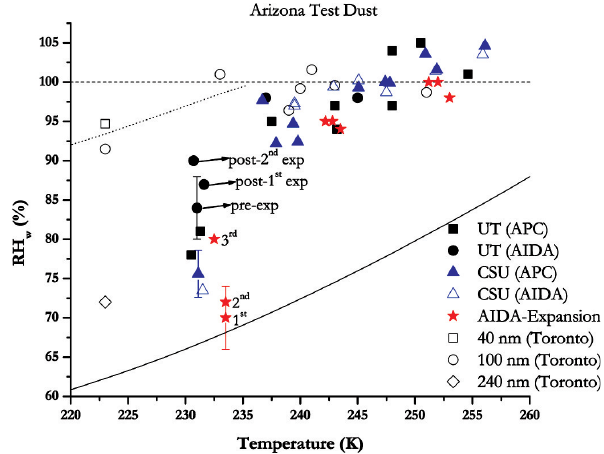
Fig. 3. Comparison of onset RH w for 0.1% activated ice frac- tion as a function of temperature for Arizona Test Dust aerosols between UT, CSU and AIDA experiments. UT-CFDC data based on 5µm channel except for the size selected studies where back- grounds were low enough to use the 0.5µm channel. UT-CFDC data at RH w > 100% and T > 250K could represent ice and/or wa- ter activation. Numbers next to the stars indicate the order of the cloud expansion experiment. Pre-exp and post-exp indicate sam- pling from the AIDA chamber before and after successive cloud ex- pansion experiments. Error bars represent uncertainty in RH mea- surements. Dashed and solid lines: Water and ice saturation, re- spectively (Murphy and Koop, 2005). Dotted line: Homogeneous freezing conditions for 0.1% 300nm ammonium sulphate aerosols in 10s (Koop et al., 2000; DeMott et al.,